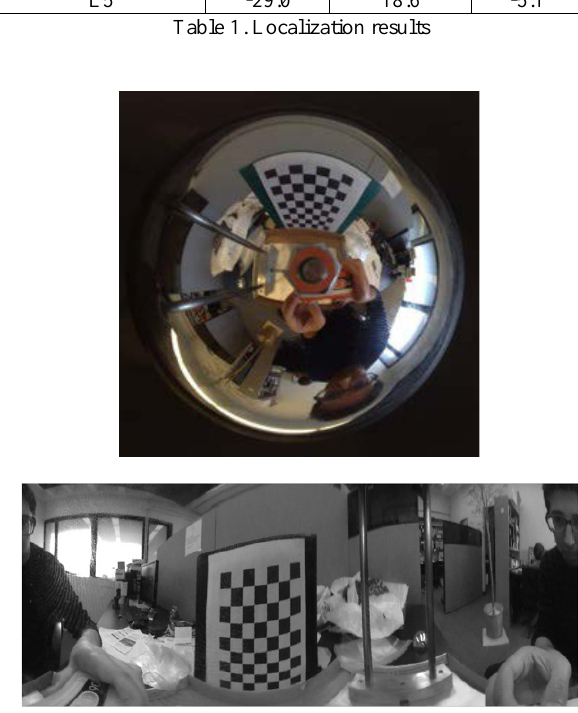
Figure 11: Unwrapping of the catadioptric